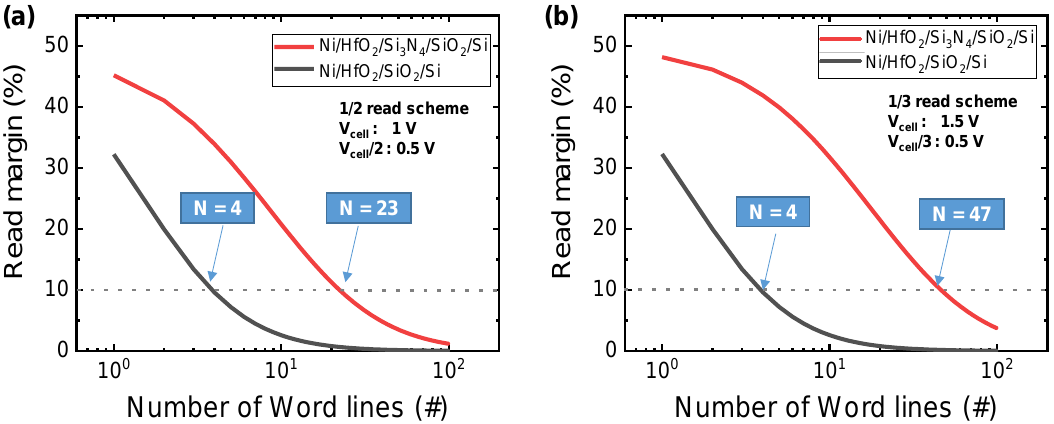
Figure 4. Read margin of Ni/HfO 2 /SiO 2 /Si and Ni/HfO 2 /Si 3 N 4 /SiO 2 /Si devices when applying ( a ) 1/2 read scheme and ( b ) 1/3 read scheme in cross-point array.